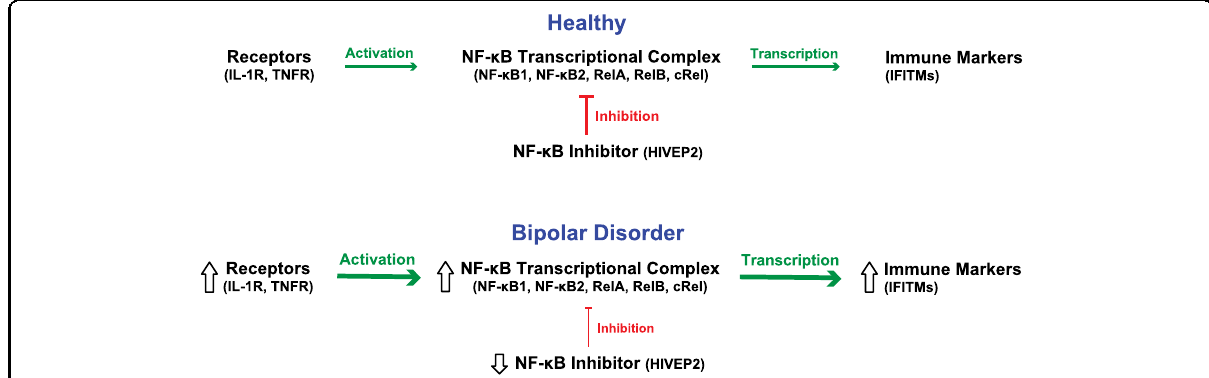
Fig. 1 NF- κ B activation pathway in bipolar disorder. The NF- κ B transcriptional complex is composed of heterodimers between NF- κ B family members, including NF- κ B1, NF- κ B2, and other members of the NF- κ B family that contain Rel homology domains including RelA, RelB, and cRel. Receptor activation (IL-1R, TNFR) increases transcriptional activity (green arrow) of the NF- κ B transcriptional complex, leading to higher mRNA levels for NF- κ B-regulated immune markers, such as IFITMs. In contrast, the NF- κ B site-binding protein HIVEP2 inhibits NF- κ B transcriptional activity (red line). Transcript levels in bipolar disorder subjects relative to unaffected comparison subjects are indicated by the direction of the open